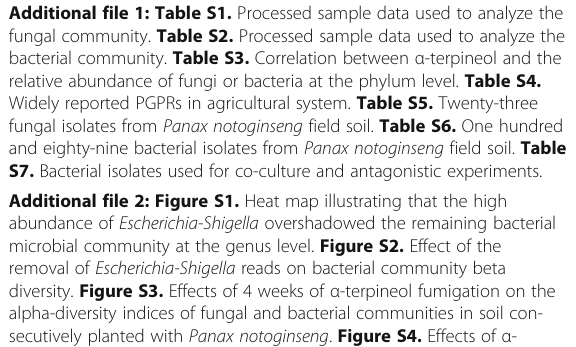
Statistical analysis